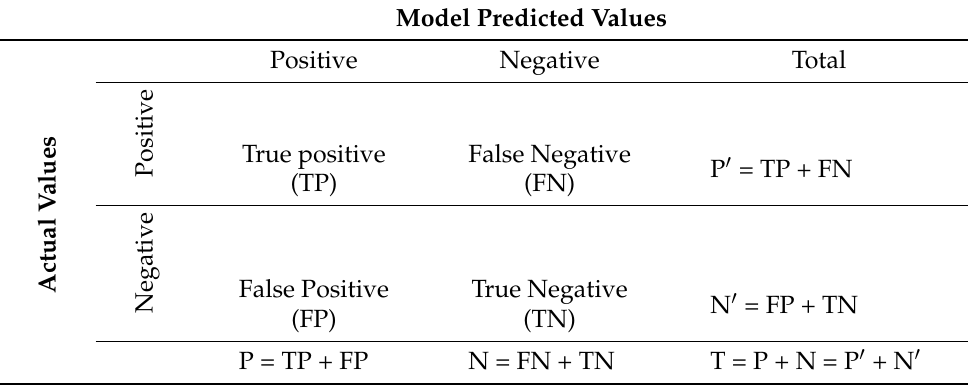
Table 1. Confusion